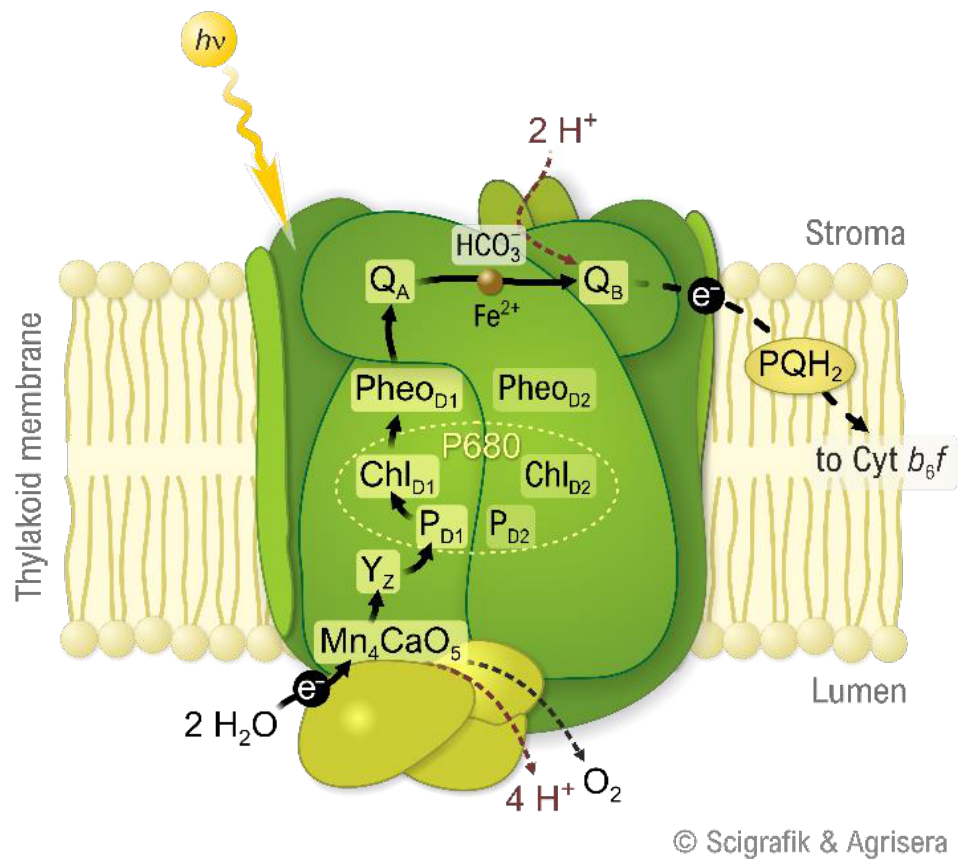
Figure 4. Photosystem II: The water-splitting enzyme of photosynthesis. D1 and D2 are the central polypeptides in a very large complex in the thylakoid membranes of cyanobacteria and chloroplasts. Electrons from water are transferred via the “Mn 4 CaO 5 ” cluster, the tyrosine Y z in D1, P680 (an ensemble of chlorophyll a molecules), Pheo (pheophytin), and Q A (a molecule of plastoquinone attached to D2) to Q B , another molecule of plastoquinone, which, after receiving two electrons, dissolves in the membrane and will be used as reductant in further reactions (as PQH2). Reproduced with permission of SciGrafik (Sweden) and Agrisera (Sweden).